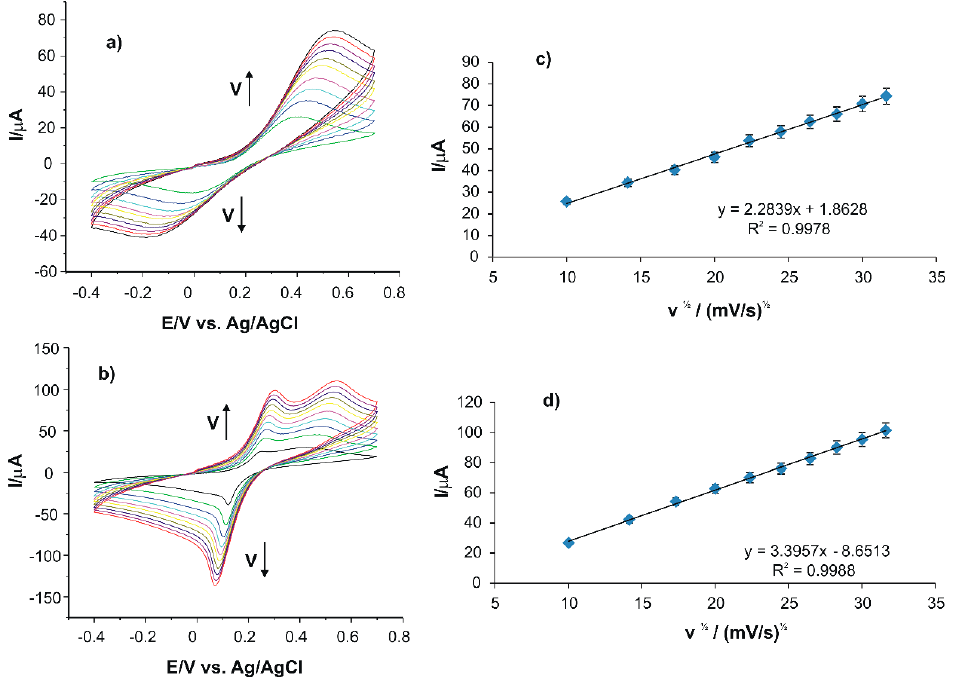
Figure 2. Cyclic voltammograms of the SPCE sensor ( a ) and the PB/SPCE sensor ( b ) immersed in a double solution of potassium ferrocyanide 10 − 3 M—potassium chloride 10 − 1 M, at scan rates between 0.1–1.0 V·s − 1 . The dependence between the values of the anodic current and the square root of scan rates for SPCE ( c ) and PB/SPCE ( d ). For redox processes of ferrocyanide/ferricyanide, it was observed that the current increased when the scan rate increased too. In order to determine which stage was limiting the rate of the electrochemical oxidation process, the dependencies between I pa and the scan rate were verified, namely the square root of the scan rate. For both sensors, good